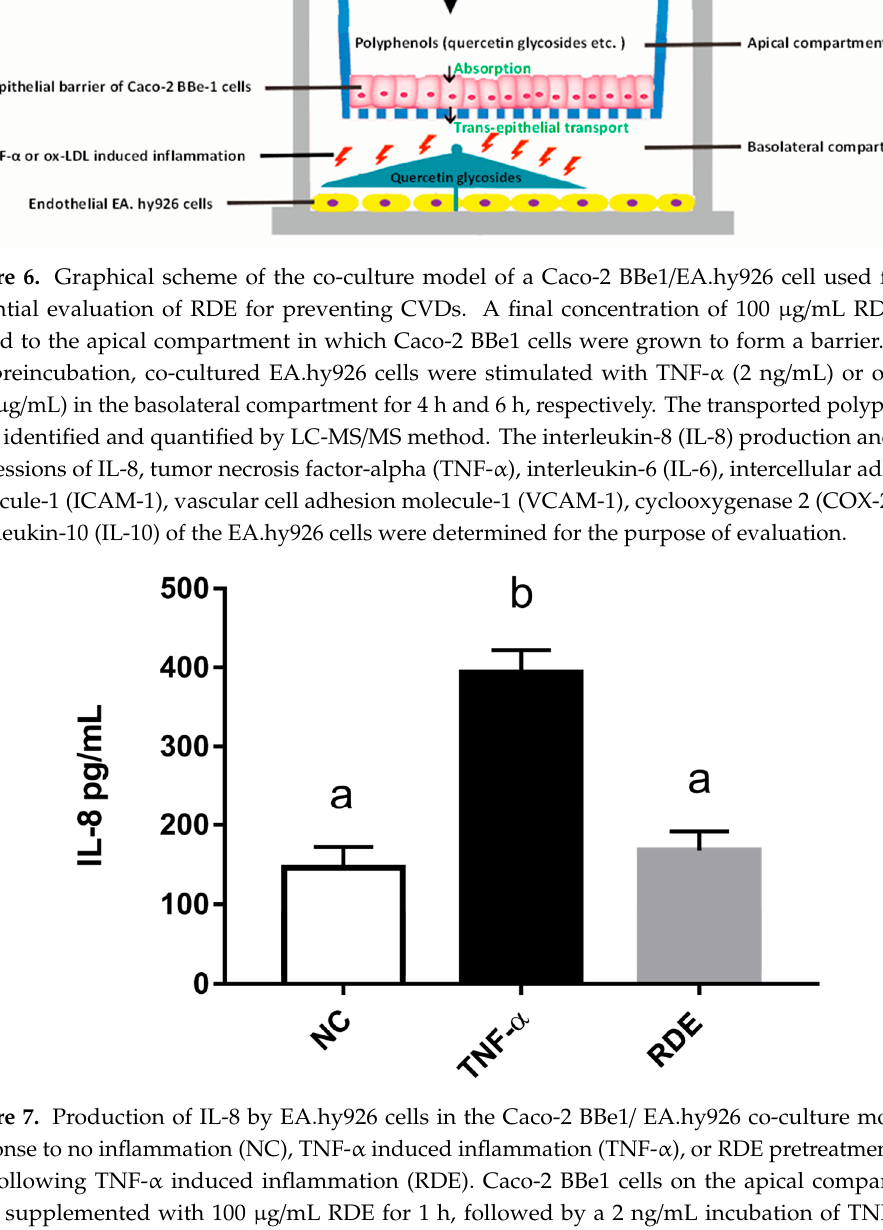
Figure 7. Production of IL-8 by EA.hy926 cells in the Caco-2 BBe1 / EA.hy926 co-culture model in response to no inflammation (NC), TNF- α induced inflammation (TNF- α ), or RDE pretreatment with the following TNF- α induced inflammation (RDE). Caco-2 BBe1 cells on the apical compartment were supplemented with 100 µ g / mL RDE for 1 h, followed by a 2 ng / mL incubation of TNF- α on the EA.hy926 cells for 4 h. Values are presented as means ± SEM, n = 4. Shared letters indicate no significant di ff erence ( p >